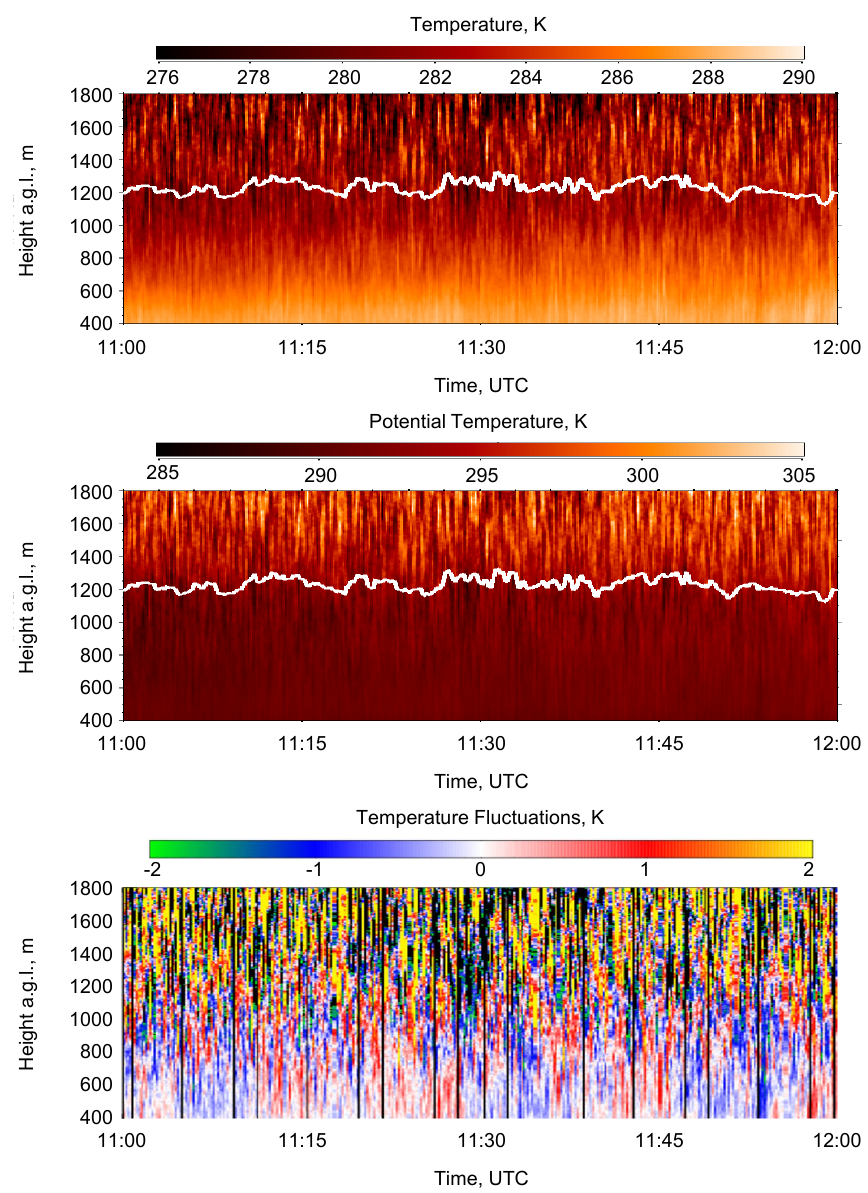
Figure 5. Same as Fig. 2 but for temperature, potential temperature, and detrended temperature fluctuations: time–height cross sections measured with the UHOH RRL on 24 April 2013 between 11:00 and 12:00UTC. The temporal and spatial resolution of the data is (cid:49)t = 10s and (cid:49)z = 3 . 75m with a gliding average of 109m. The instantaneous CBL heights determined with the Haar-wavelet analysis are marked (same as shown in Fig. 2). a.g.l. (above ground level). (Black vertical lines are gaps which result from gridding the data to exact 10s intervals; these artifacts do not influence the turbulence